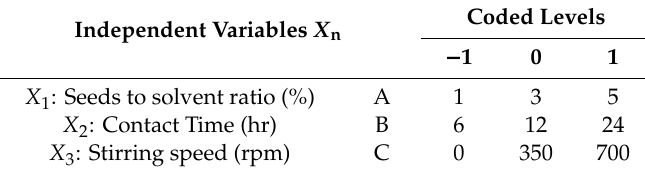
Table 1. Experimental design variables used for modeling Sesame seeds oil